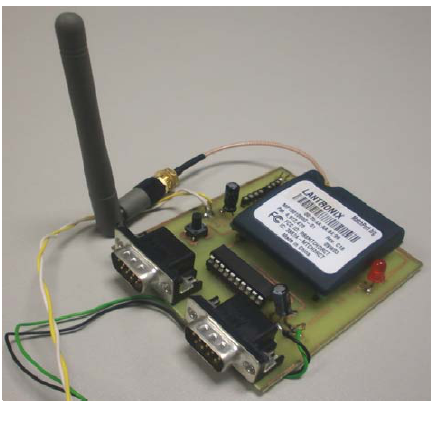
Figure 2. Image of the underwater wireless sensor node.